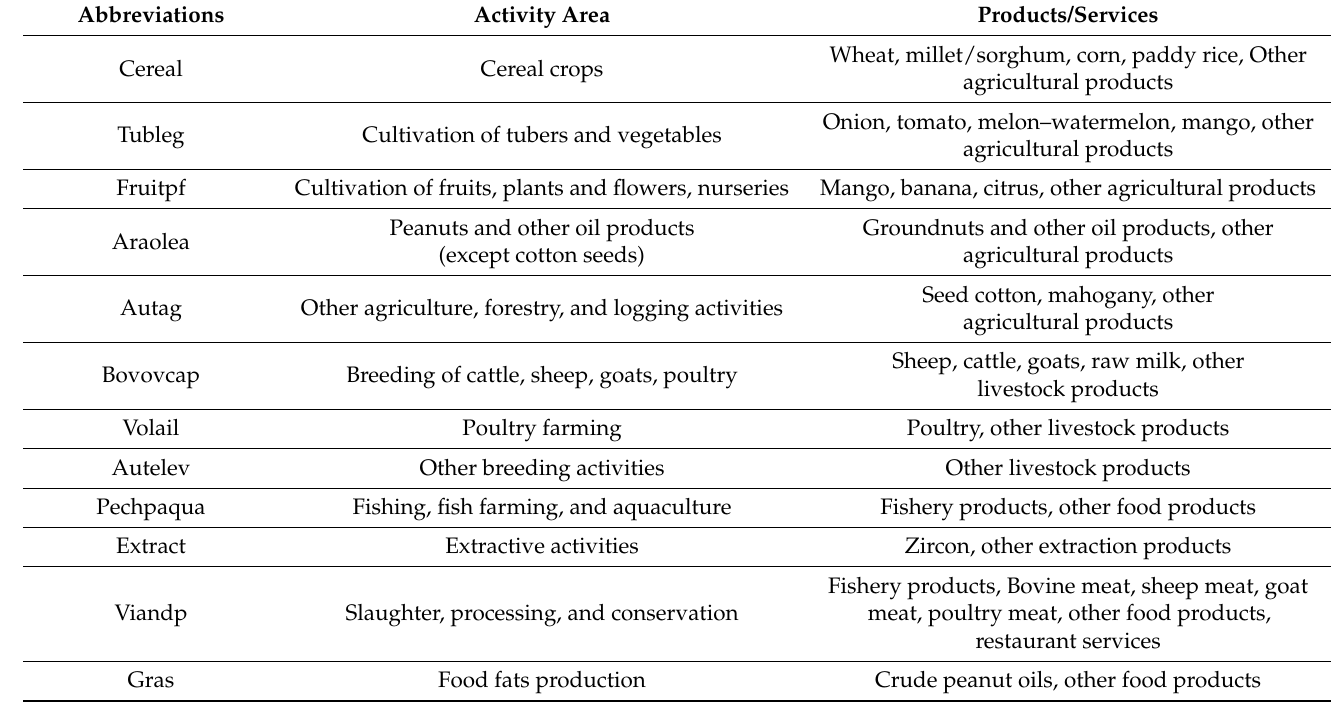
Table A1. Description of the 27 business sectors and